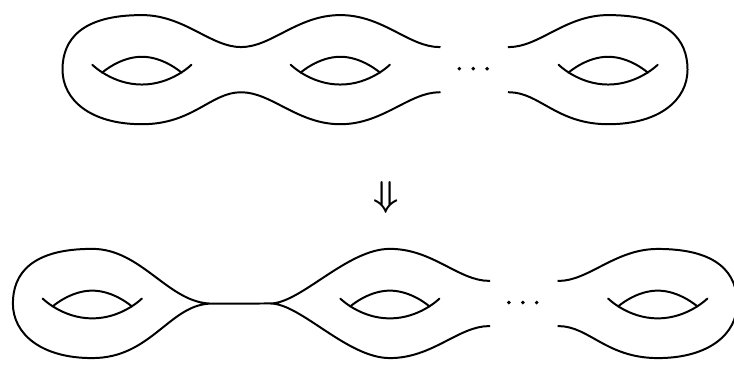
Figure 1. Factorization of a genus g Riemann